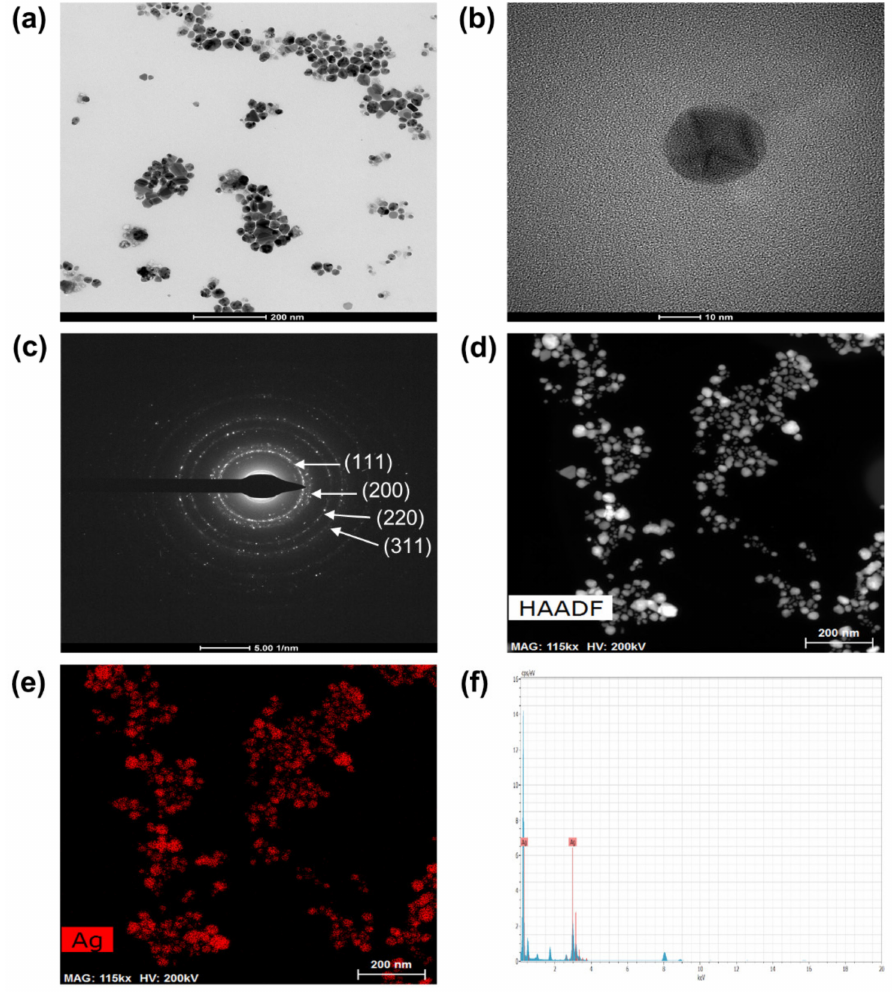
Figure 3. High-resolution transmission electron microscopy (HR-TEM) images ( a , b ), selected area electron diffraction (SAED) pattern ( c ), HAADF (High-angle annular dark-field) images ( d , e ) and energy-dispersive X-ray spectroscopy (EDX) spectra ( f ) of SS-AgNPs. 58 k ( a ), 630 k ( b ), 115 k ( d , e ).